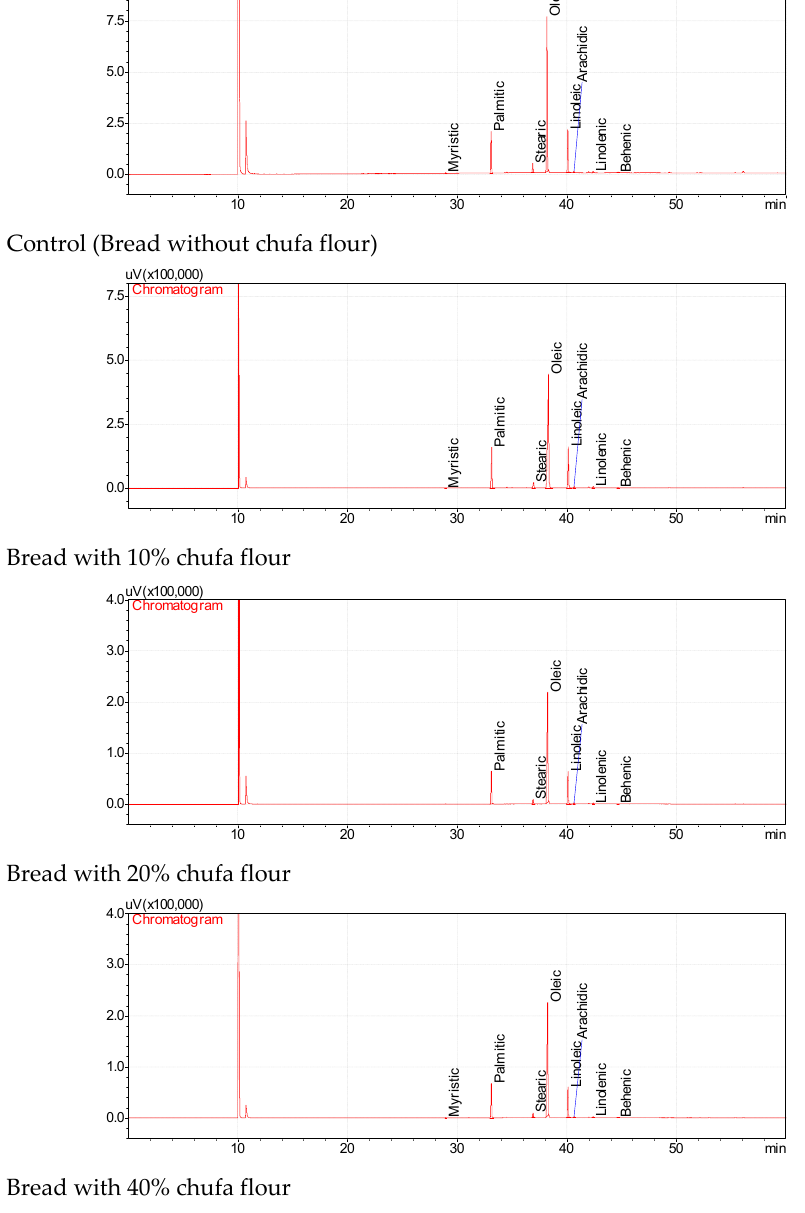
Figure 3. Fatty acid chromatograms of the oils of the breads enriched with chufa flour at different concentrations.